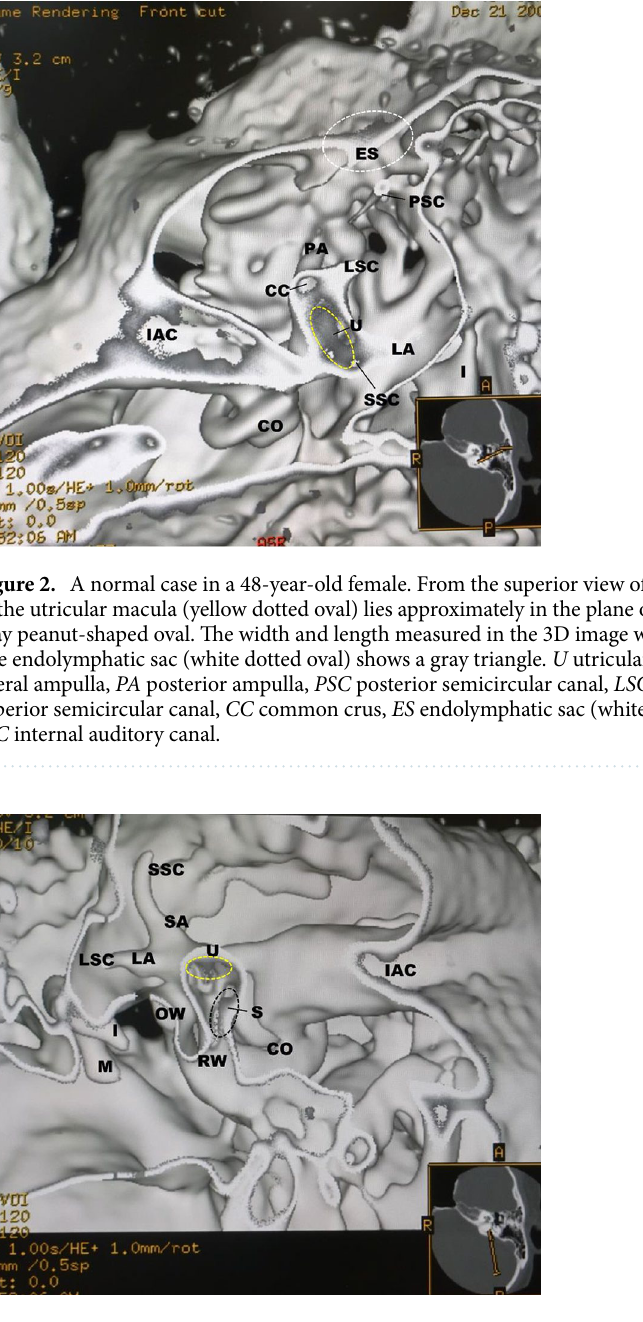
Figure 3. The coronal view from the same subject as in Fig. 2. The utricular (yellow dotted oval) and saccular (black dotted oval) maculae show gray triangles with an irregular contour. U = utricular macula (yellow dotted oval), S = saccular macula (black dotted oval), LA = lateral ampulla, LSC lateral semicircular canal, SA superior ampulla, SSC superior semicircular canal, CO cochlea, I incus, M malleus, IAC internal auditory canal, RW round window, OW oval